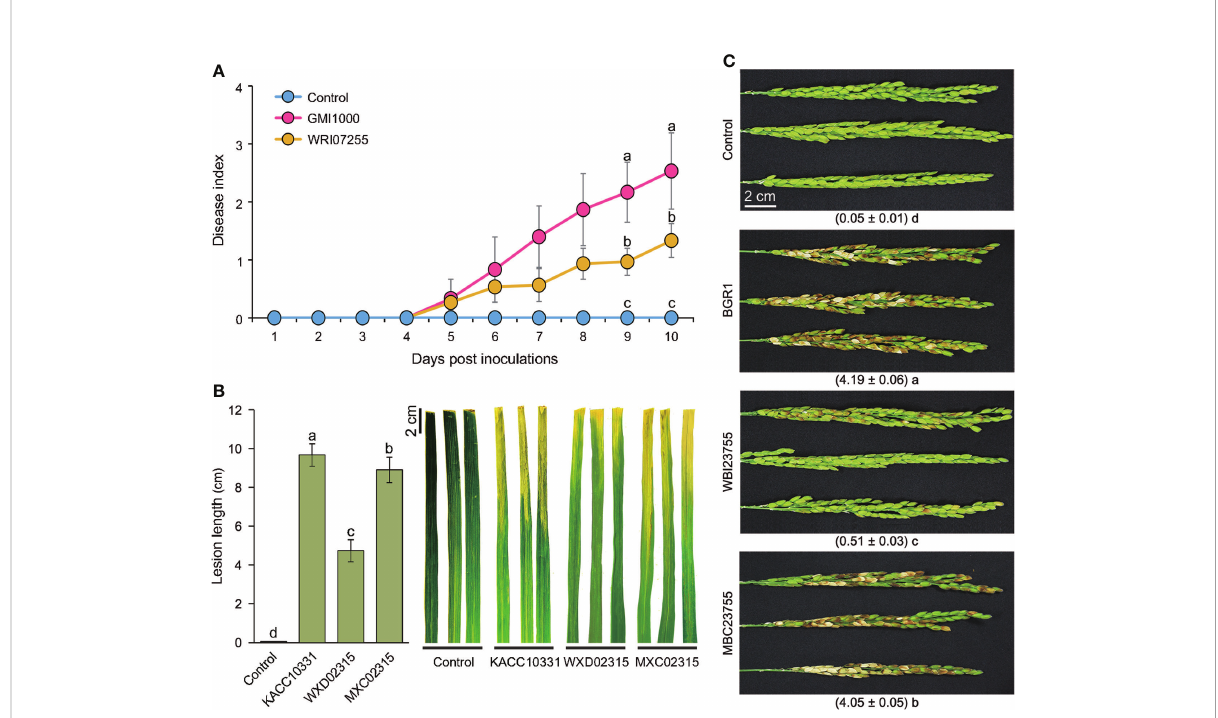
FIGURE 5 Virulence assays for PCD mutants of the three pathogens (A) Three- to four-week-old tomato plants were inoculated through the natural soil- soaking method with wildtype R. solanacearum GMI1000 and the PCD-defective mutant (WRI07255). The severity of bacterial wilt was rated daily on a disease index scale of 0 (no wilting) to 4 (76 – 100% wilted or dead). The points represent the average disease indices of 30 plants with standard errors. (B) The bar graph and error bars represent the measured average lesion lengths and the standard errors ( n = 9) and photographs of the disease symptoms were obtained 14 days after the leaf-clipping inoculation with wild-type Xoo (KACC10331), the PCD defective mutant (WXD02315) and the complemented strain (MXC02315). (C) Bacterial suspensions of the wild-type ( B ) glumae (BGR1), the PCD-defective mutant (WBI23755) and the complemented strain (MBC23755) were inoculated into rice panicles at the fl owering stage. Photographs were acquired 14 days after inoculation, and the numbers below the photographs refer to the disease index ranging from 0 (healthy panicle) to 5 (80 – 100% discolored panicle). In all virulence assays, an uninoculated samples served as negative controls. Signi fi cant virulence differences are marked with different lowercase letters indicating P ≤ 0.05 according to the least signi fi cant difference